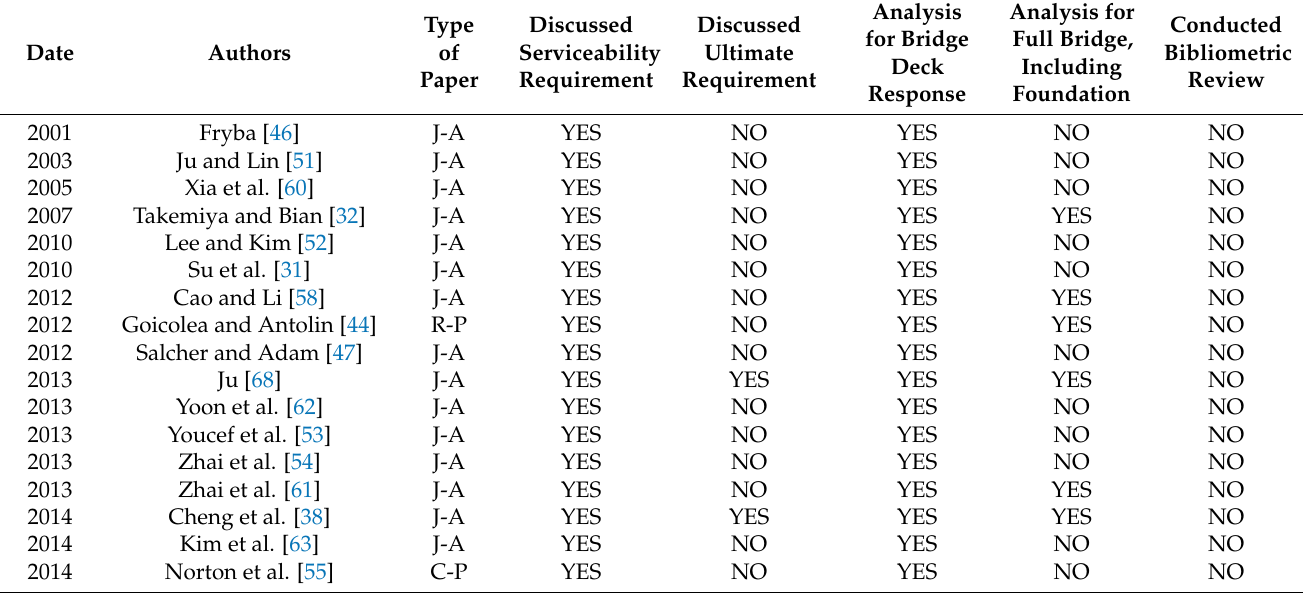
Table 3. Summary of review papers and published studies for railway bridge